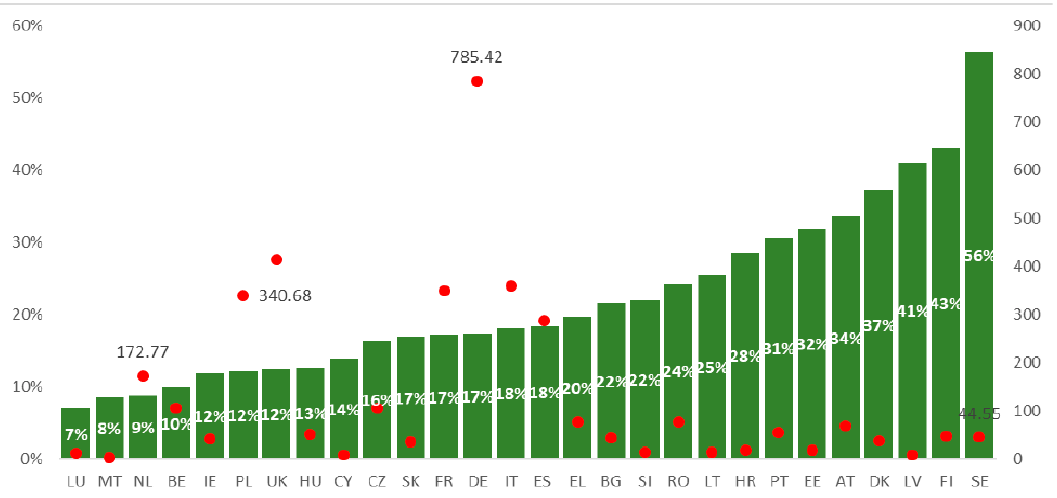
Figure 3. Share of renewable energy and GHG CO 2 emissions (Mt CO 2 per year).